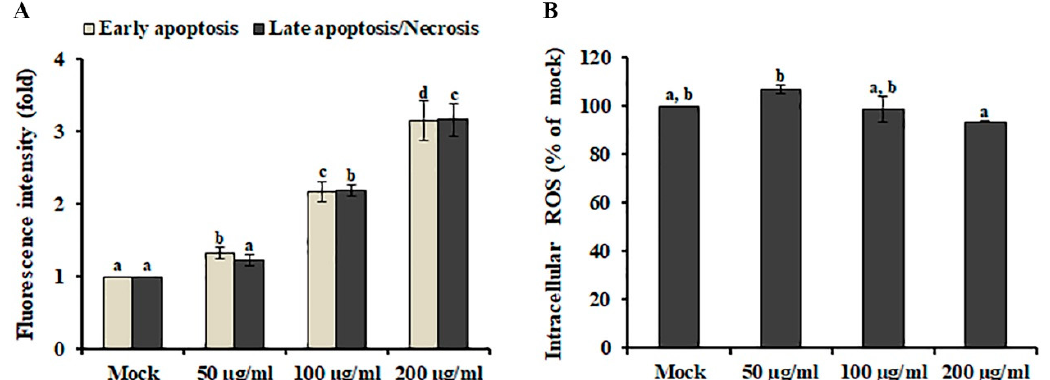
Figure 2. Analysis of Abeliophyllum distichum leaves extract (AL)-induced apoptosis and ROS production in SK-MEL-2 cells. ( A ) Early apoptotic cells and dead cells (late-stage apoptotic or necrotic cells) were analyzed using a fluorescence reader after Annexin V and PI staining. ( B ) Intracellular ROS generation was detected in SK-MEL-2 cells after treatment with different concentrations of AL by staining with DCFH-DA. The data are expressed as means ± SE. Values with different superscript letters are significantly different ( p < 0.05).